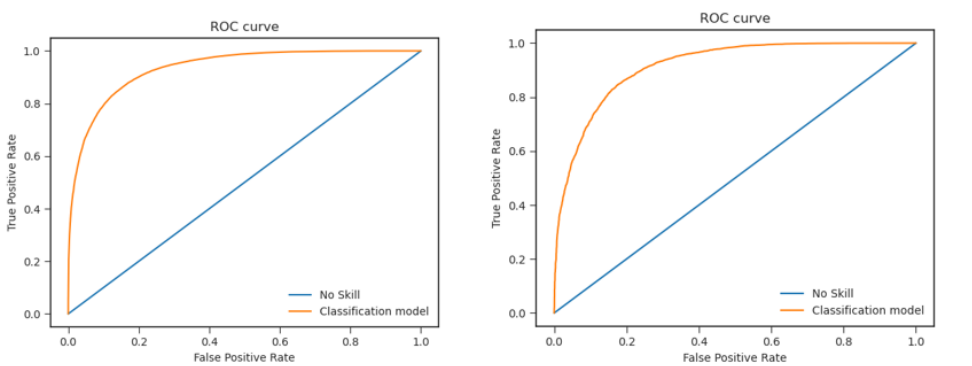
Figure 13. On the left, the ROC curve for the summer analysis. On the right, the ROC curve related to the winter